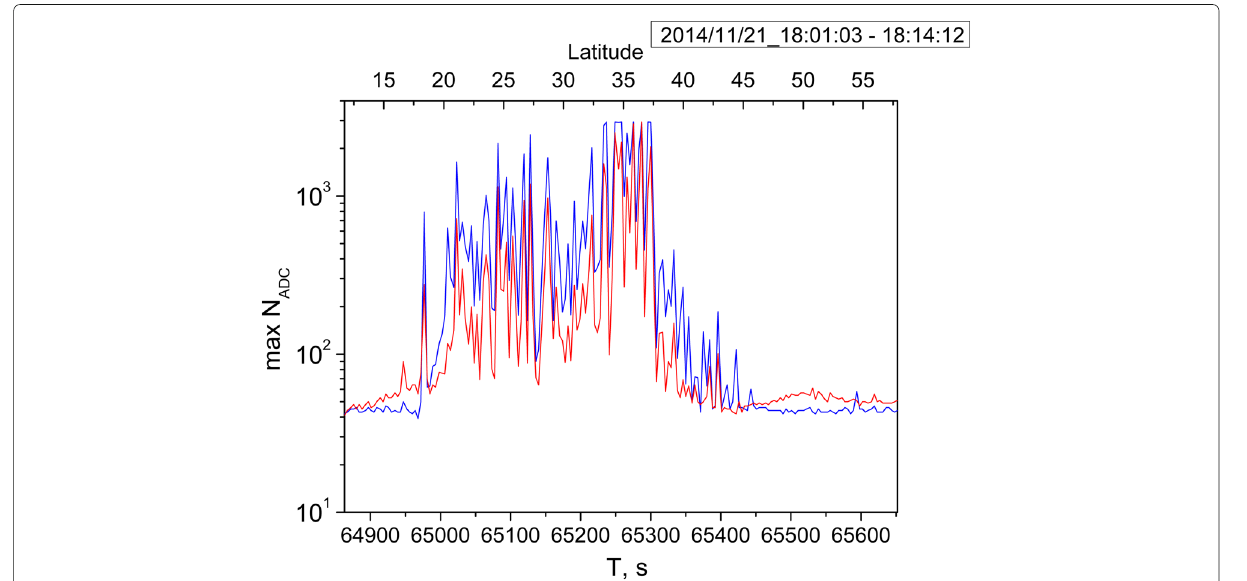
Fig. 1 Example of series of TAE in the Vernov experiment (blue curve—UV emissions; red—infrared one)